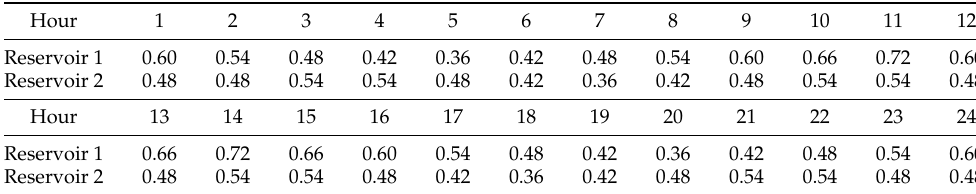
Table 1. The hourly inflow to the reservoir (10 4 m 3 ).